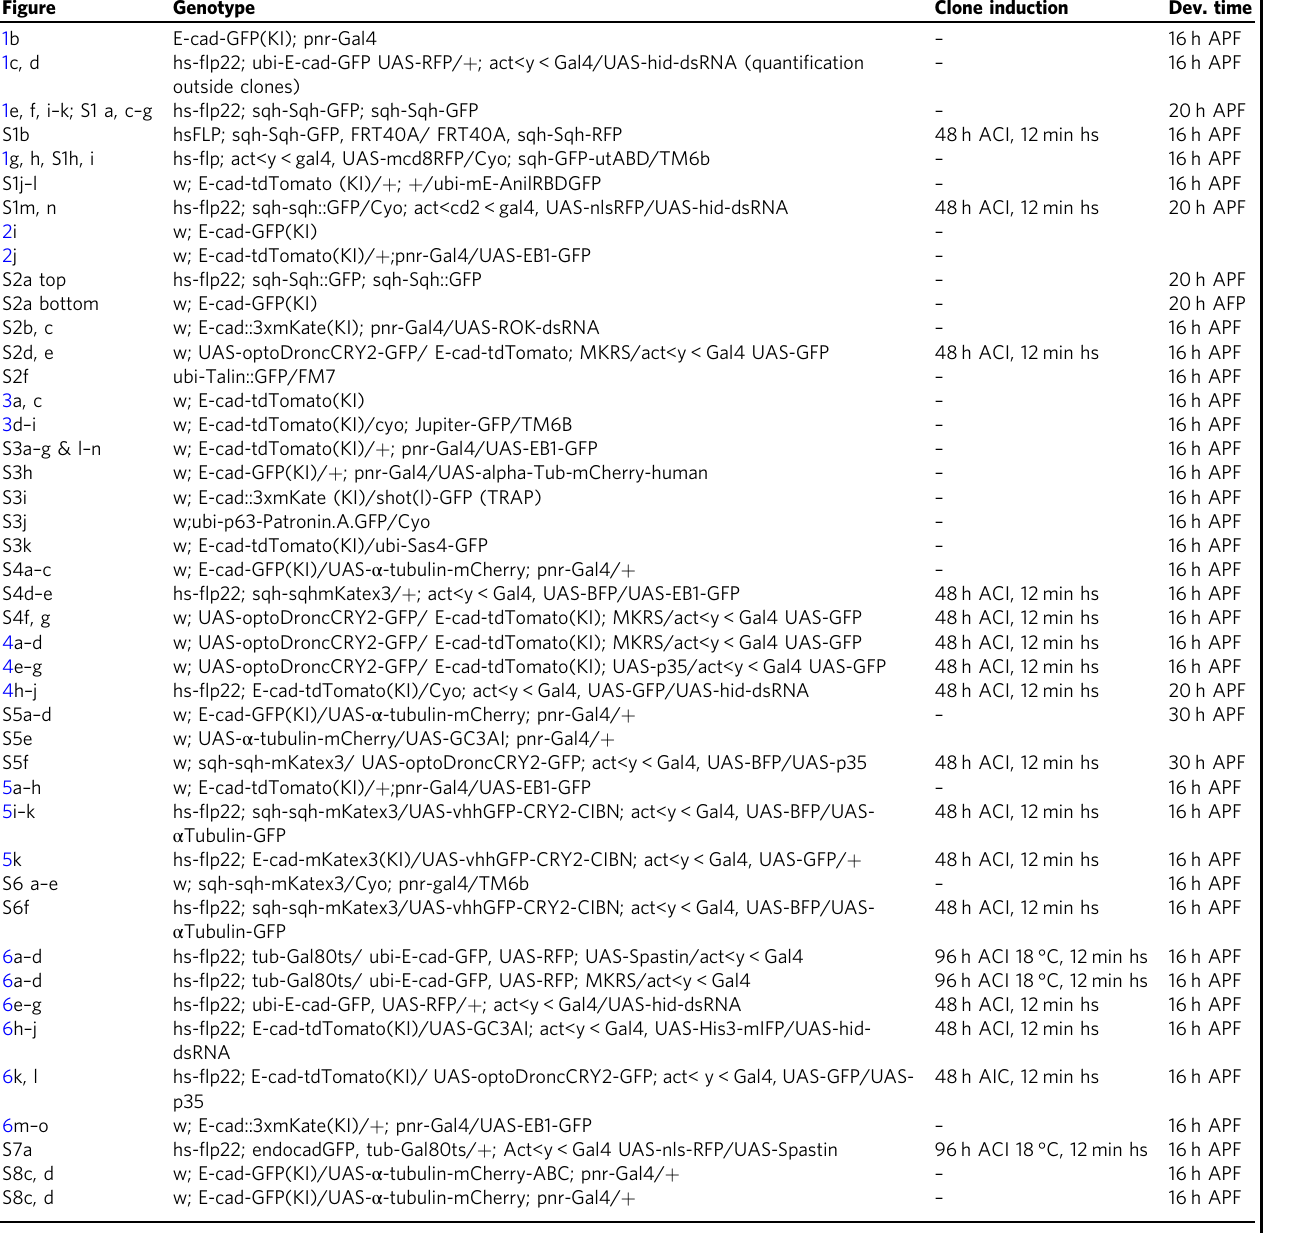
Table 2 Precise genotype used for each fi gure panel. Figure